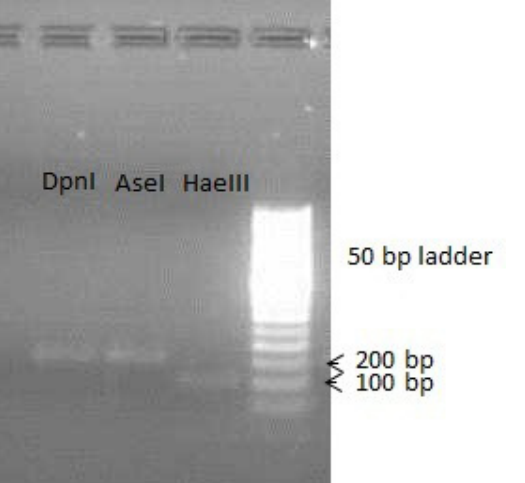
matched the Jungle Cat.